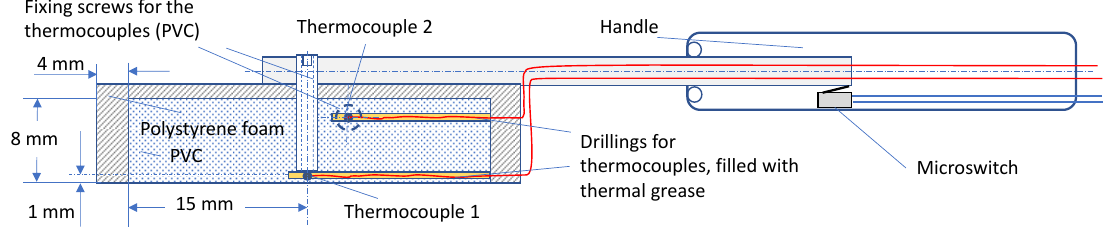
Figure 1. Structure of the measuring spoon with thermocouples (sectional view, schematic).